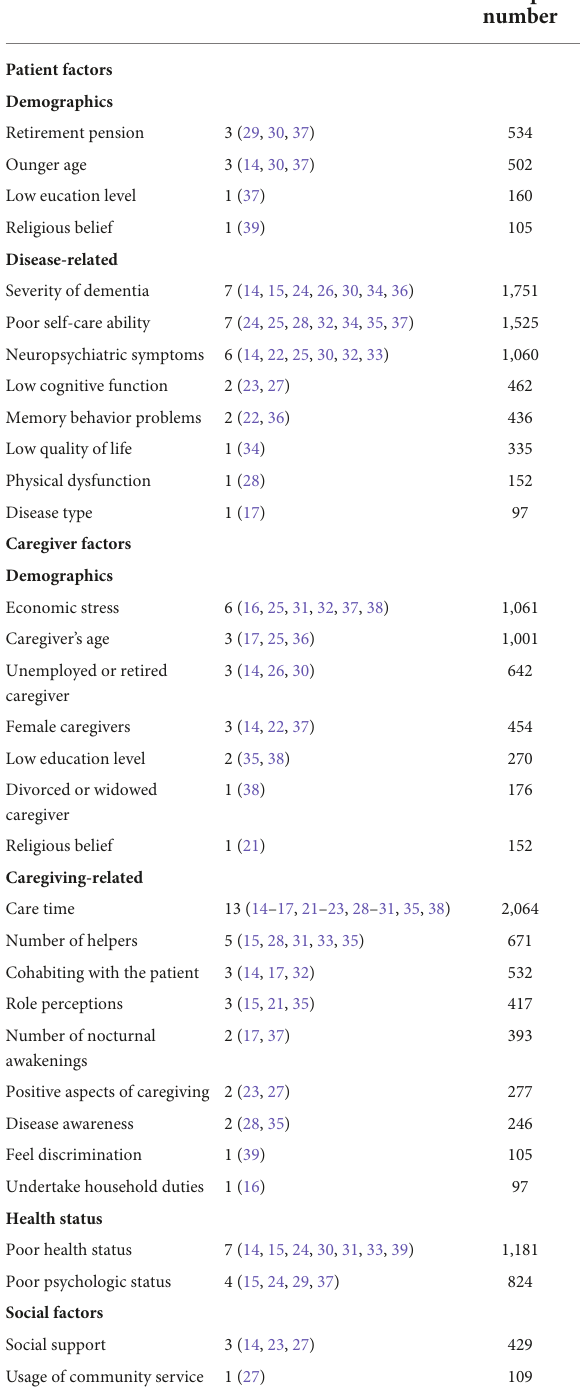
TABLE 1 Summary of factors associated with caregiver